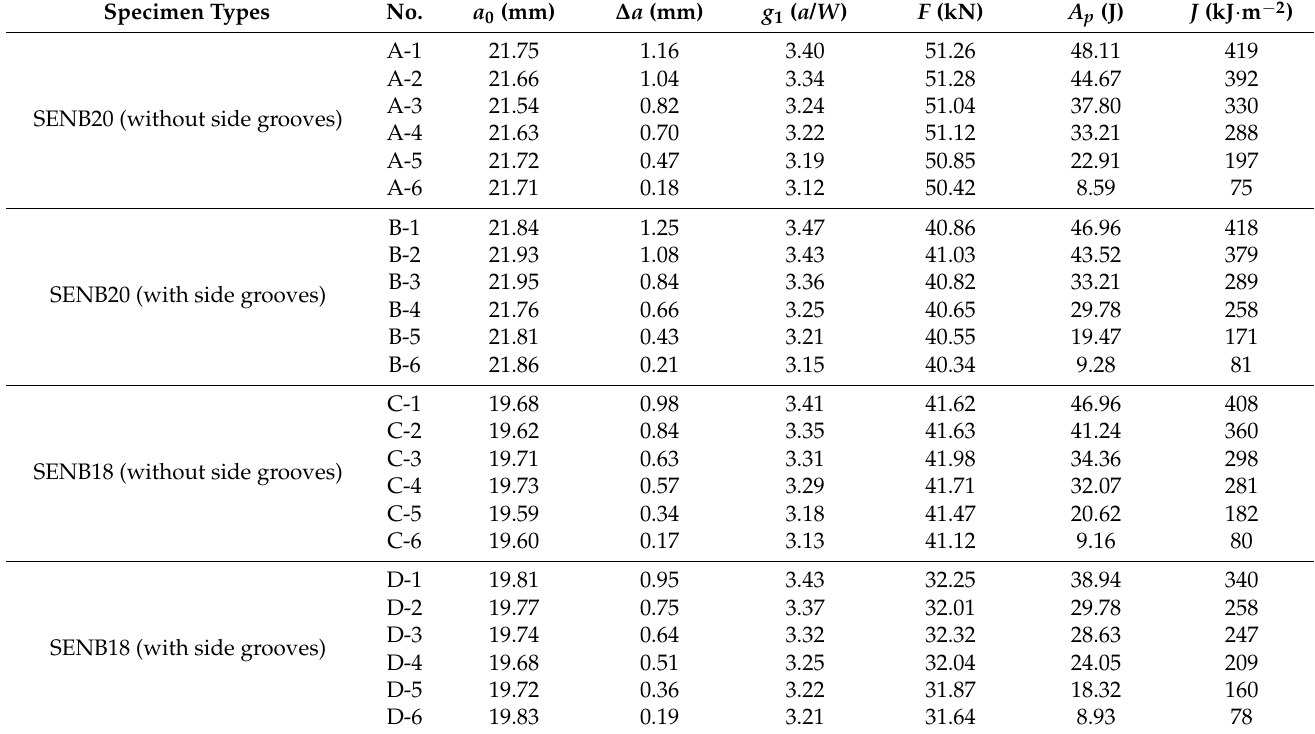
Table 6. Fracture toughness characterized by J-integral value of each specimen at room